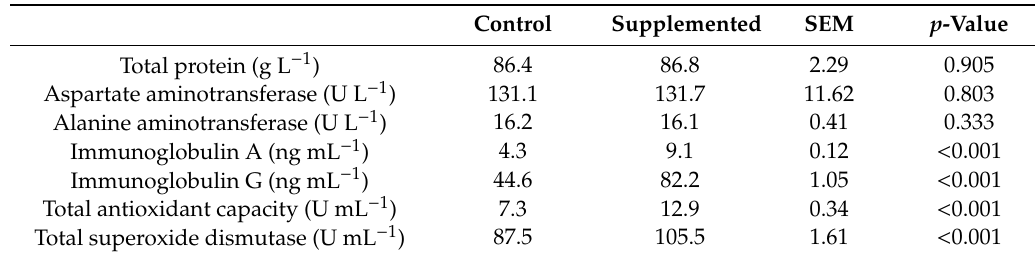
Table 2. E ff ects of a 4.5% licorice root extract supplementation on blood indices of Karakul sheep fed cottonseed hull-based diets.